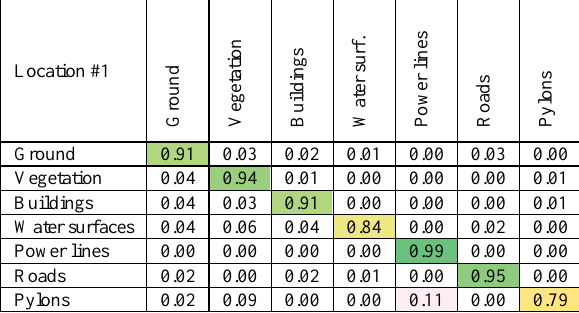
Table 5. Confusion matrix after multi-source semantic segmentation of Location #1.